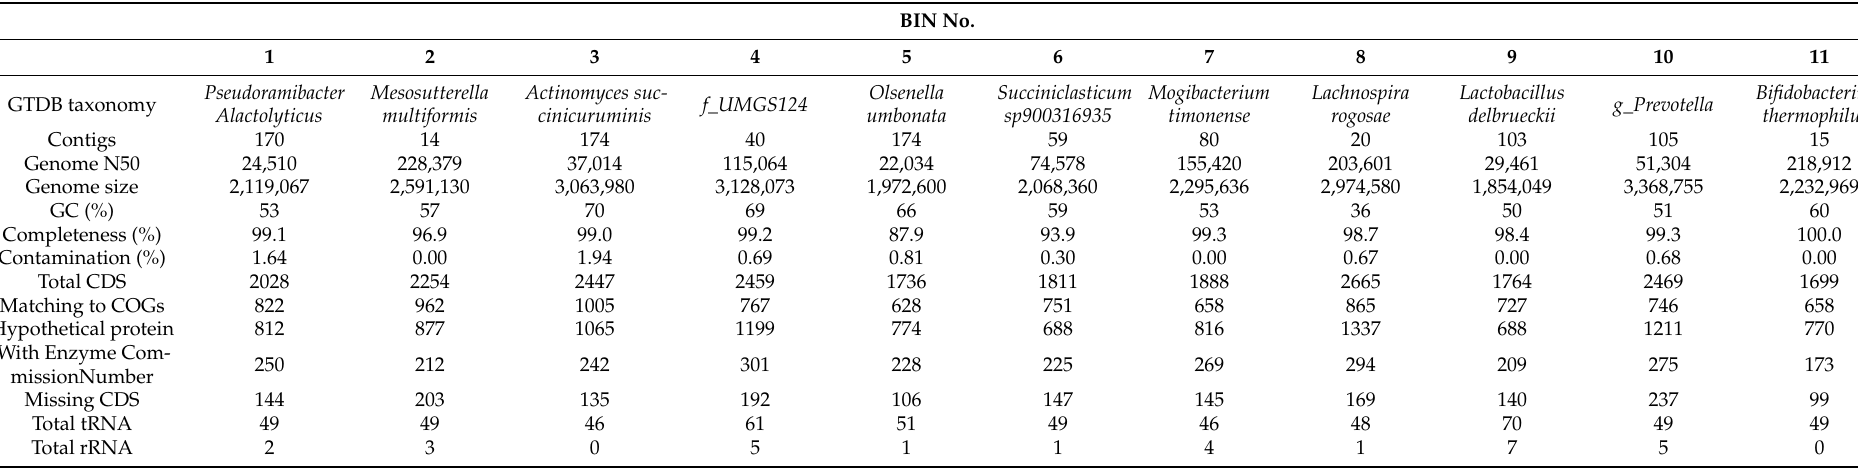
Table 3. Sequencing and assembly statistics and PROKKA annotation results. Contigs, number of contigs; Genome N50, the shortest contig length needed to cover 50% of the genome; genome size, the total length of each bin; GC, the content (%) of guanine-cytosine (GC) nucleotides; total coding sequences (CDS), number of predicted CDS; matching to COGs (Clusters of Orthologous Groups), number of CDS in COG classification; missing CDS, number of CDS not classified in COG. BIN